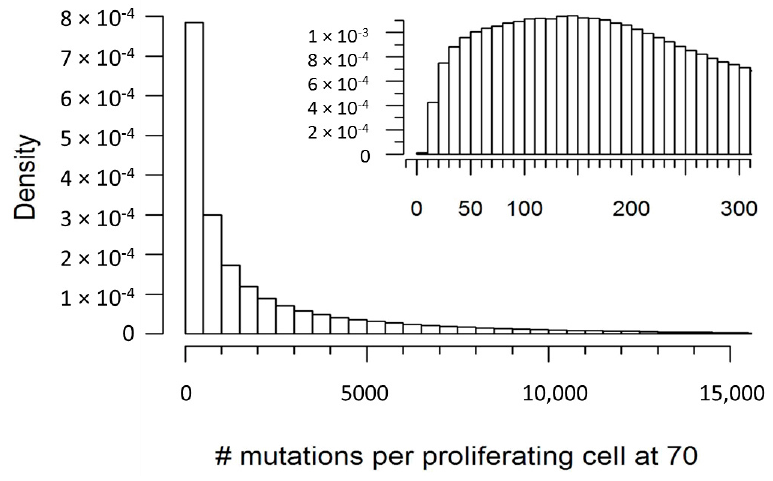
Figure 1. Simulated distribution of mutations per proliferating cell at the age of 70.